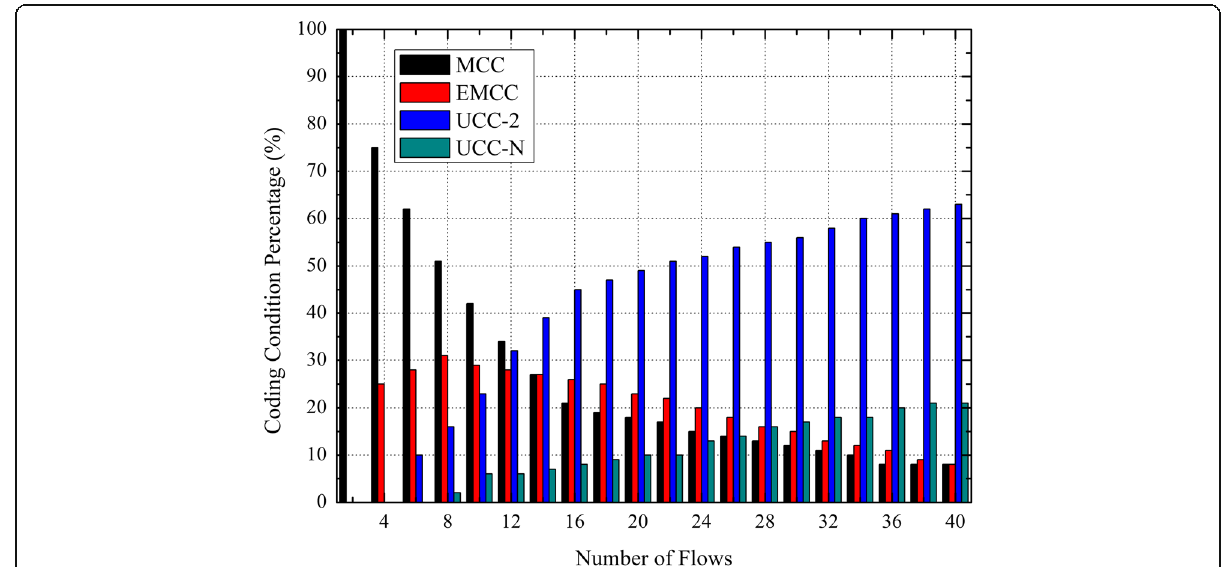
Fig. 24 Coding condition percentage of NAER under different number of flows in grid network. Figure 24 shows the coding condition percentage comparison of NAER under different number of flows in grid